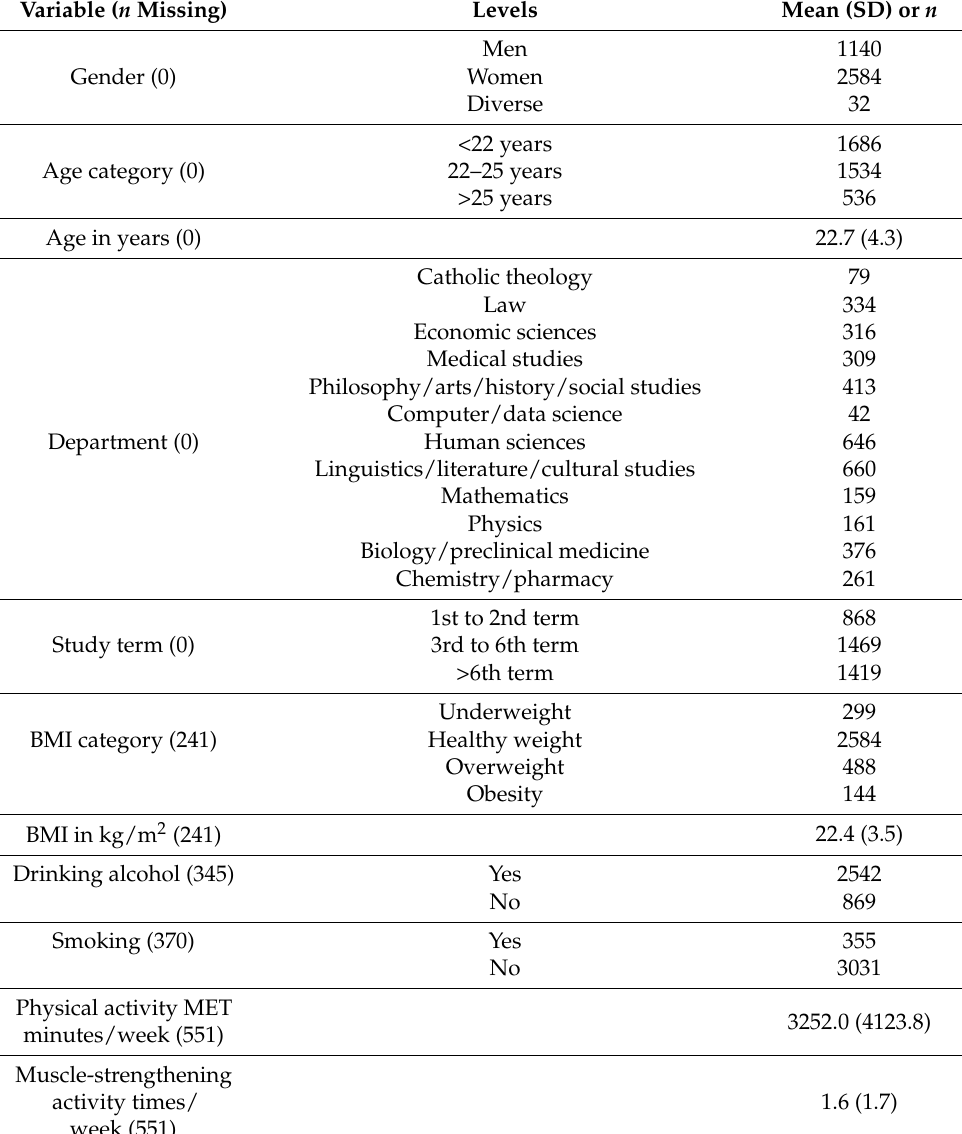
Table 1. Baseline characteristics of the study participants ( n = 3756). Variable ( n Missing) Levels Mean (SD) or